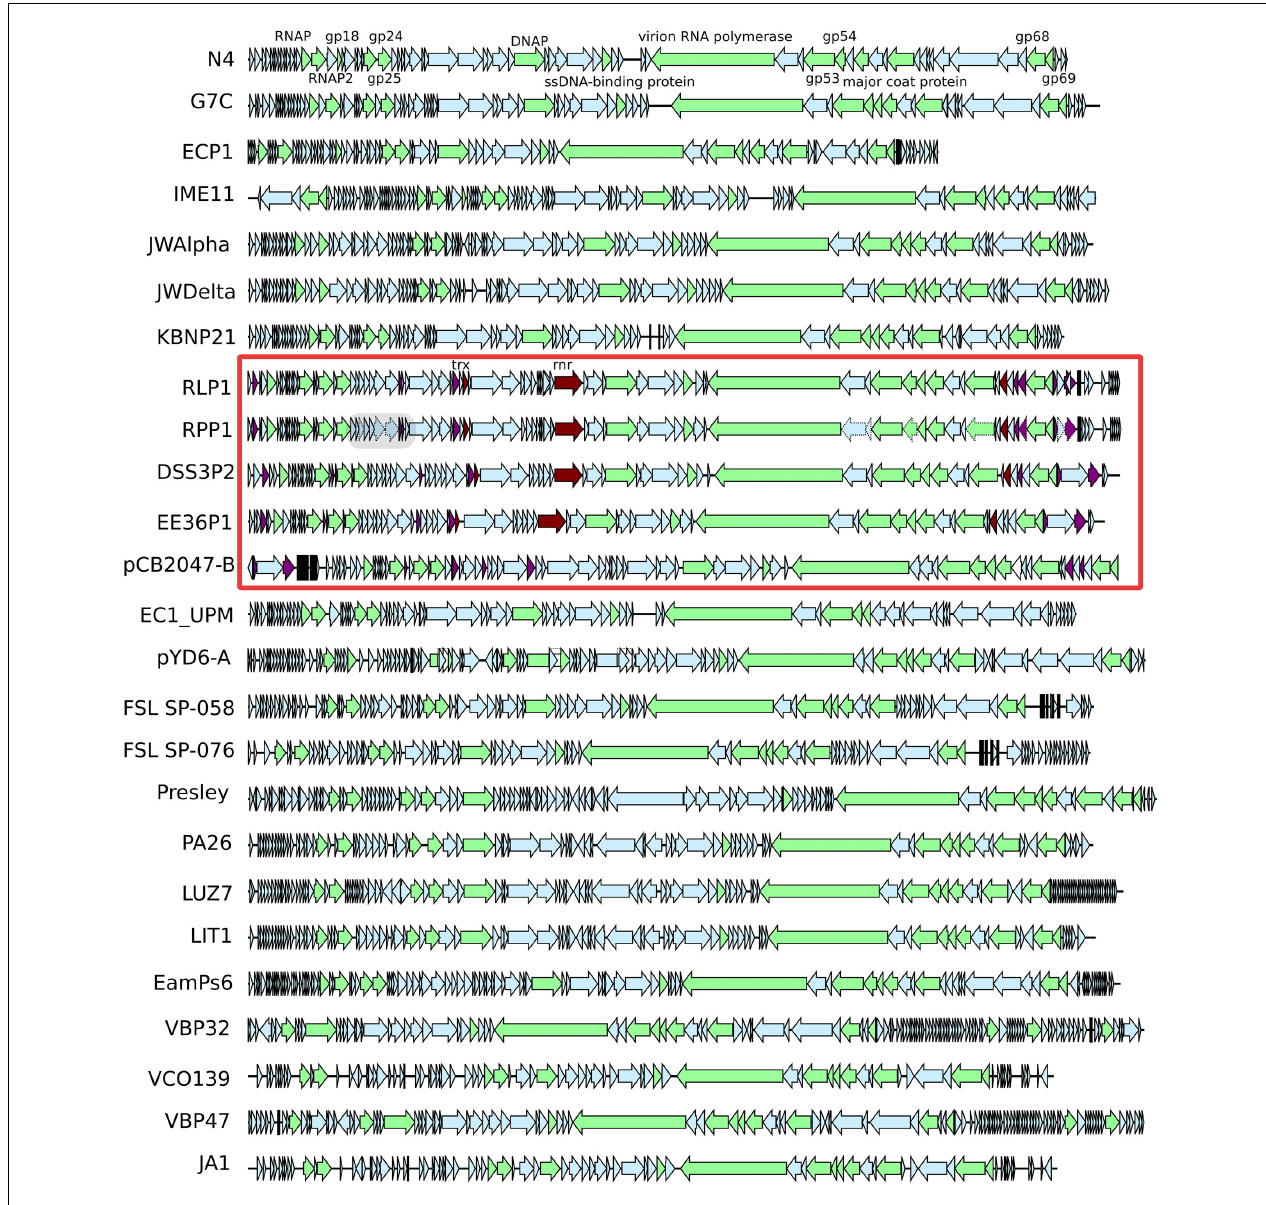
FIGURE 4 | Comparison of 25 N4-like phage genomes. Arrows represent the predicted ORFs and point in the direction of transcription. N4-like core genes are shaded in green and labeled with N4 phage homolog ORF numbers, host-like genes found in Roseobacter N4-like phages are shaded in red, and finally experimentally determined